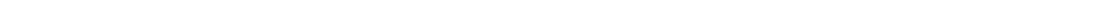
Figure 7 | LUBAC is required for peripheral Treg cell homeostasis and tolerance. ( a ) Kaplan–Meyer survival curve measured from birth to 60 days for mice of the indicated genotypes ( P o 0.0001 using the log-ranked Mantel–Cox test). ( b ) Weights of 18–22-day-old male and female Hoip D Foxp3 mice and healthy littermate controls. ( c ) Runted appearance and ( d ) lymphadenopathy observed in Hoip D Foxp3 mice, with mean cell number indicated. ( e ) Representative hematoxylin and eosin (haematoxylin and eosin) stained sections of lung, liver and pancreas of 21-day-old mice of the indicated genotypes (scale bars, 500 m m). ( f ) Plasma IgE concentrations in 18–22-day-old Hoip D Foxp3 mice and healthy littermate controls. ( g ) Expression of CD44 and CD62L on CD4 þ FOXP3 (cid:2) (top panel) and CD8 þ T cells (bottom panel) in spleens of WT and Hoip D Foxp3 mice. ( h ) Absolute numbers of CD44 high CD62L low activated cells in the CD4 þ FOXP3 (cid:2) and CD8 þ population of WTand Hoip D Foxp3 mice. ( i ) Representative flow cytometry plots and absolute numbers of FOXP3 þ TCR b þ cells in the thymus (top panel), spleen (middle panel) and lymph nodes (bottom panel) of WTand Hoip D Foxp3 mice. ( j ) Expression of Ki-67, CTLA-4, CD62L and BCL-2 in CD4 þ FOXP3 þ cells in the spleen from WT (grey shaded histogram) and Sharpin cpdm (black